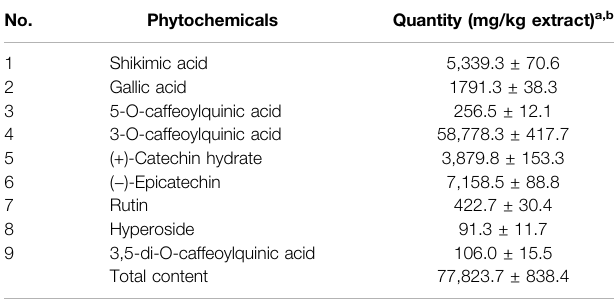
TABLE 1 | Quantitative determination of metabolites in the methanolic extract Polypodium vulgare L. by HPLC-DAD reported at 272 nm.